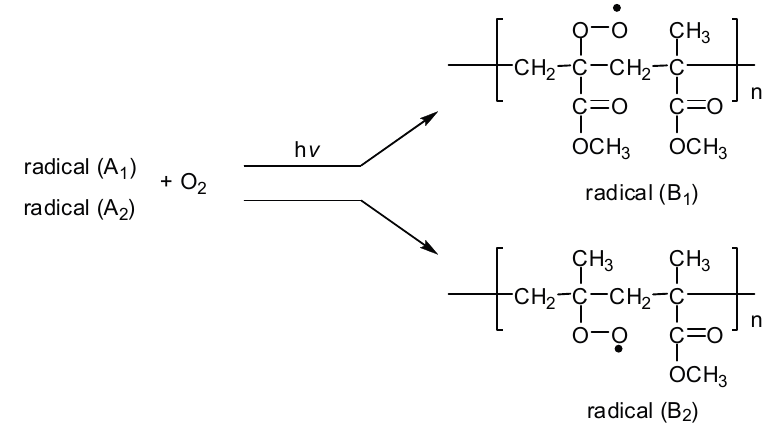
Figure 3. Formation of radicals B 1 and B 2 .